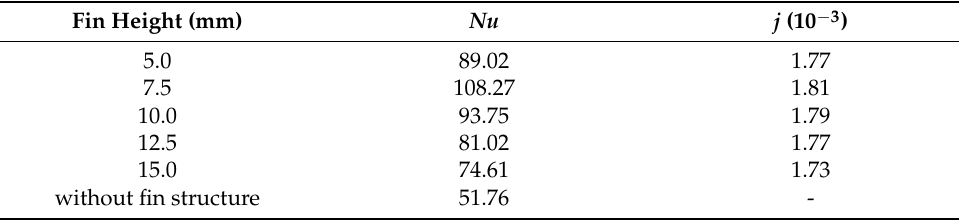
Table 2. Nusselt number and Colburn factor under different fin height h.